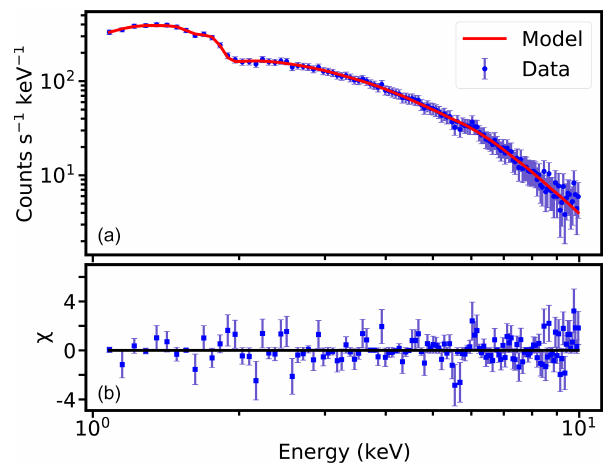
Figure 7. The modelled light curves from Insight-HXMT for the X-ray Earth occultation of the Crab Nebula. The blue, cyan, red, and green predicted light curves correspond to four different energy ranges, and these predicted light curves are all calculated based on the input data from the NRLMSISE-00 model. The normalized flux of each predicted light curve is represented with the orbital phase. It is found that the occultation depths (the difference between the highest and lowest point of the same light curve) of different energy segments are very different.